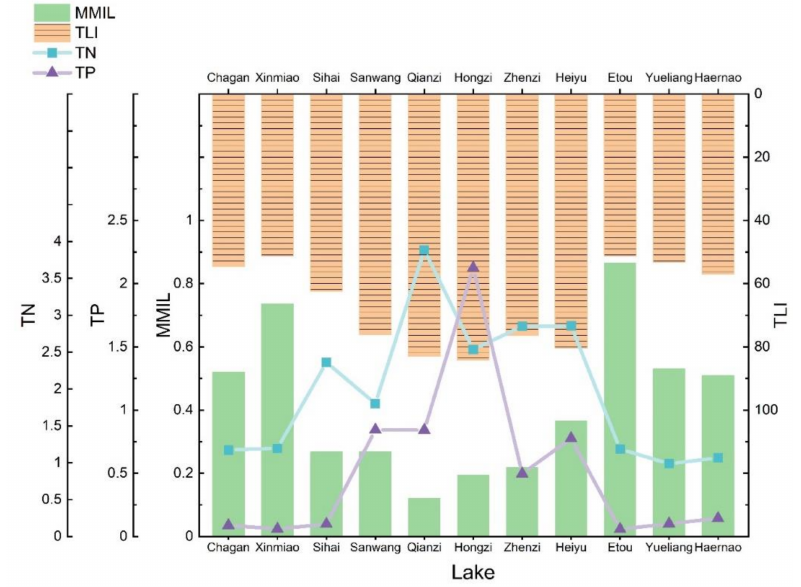
Figure 4. Comprehensive analysis of MMI value of lake (MMIL) and lake water quality indicators. The horizontal axis represents different research lakes; the y1 axis (starting from the lower x -axis) represents MMIL; the y2 axis (starting from the upper x -axis) represents trophic level index (TLI); the relative value of total nitrogen (TN) and total phosphorus (TP) were used to plot points and